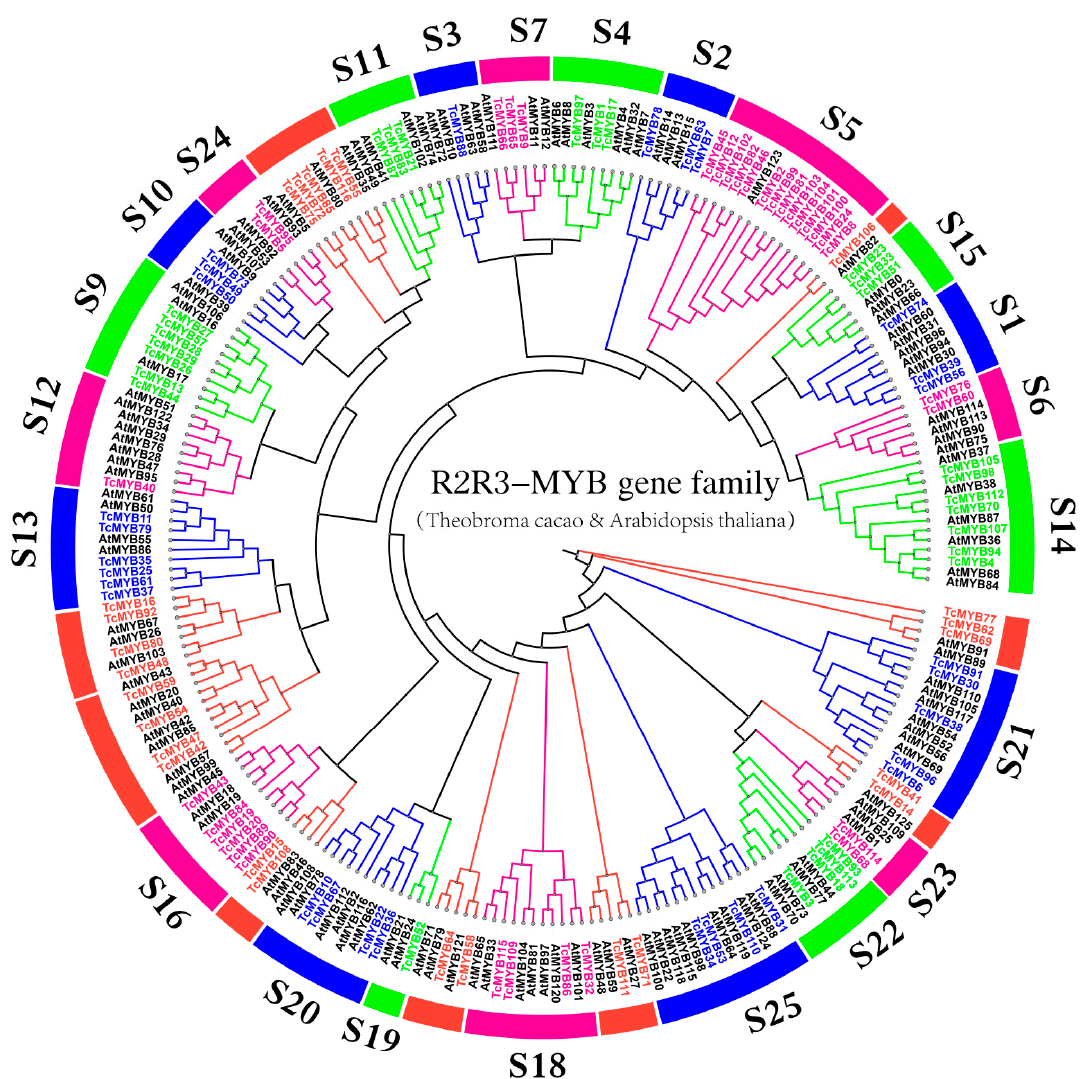
Figure 1. A rooted phylogenetic tree representing the relationships in Theobroma cacao and Arabidopsis thaliana . We used the neighbor-joining (NJ) method with 1000 bootstrap replications to construct a phylogenetic tree. The genes in Theobroma cacao are marked in green, blue and pink, which aim to distinguish the different subgroups. The genes in Arabidopsis thaliana are marked in black. The red marking for the Theobroma cacao R2R3-MYB ( TcMYB ) genes indicates that they belong to unclassified genes.